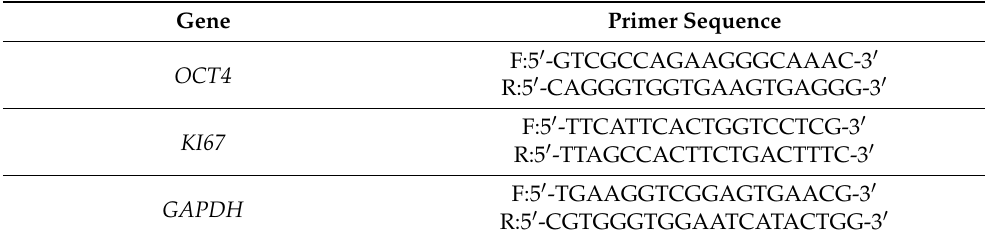
Table 1. The primer sequences in this